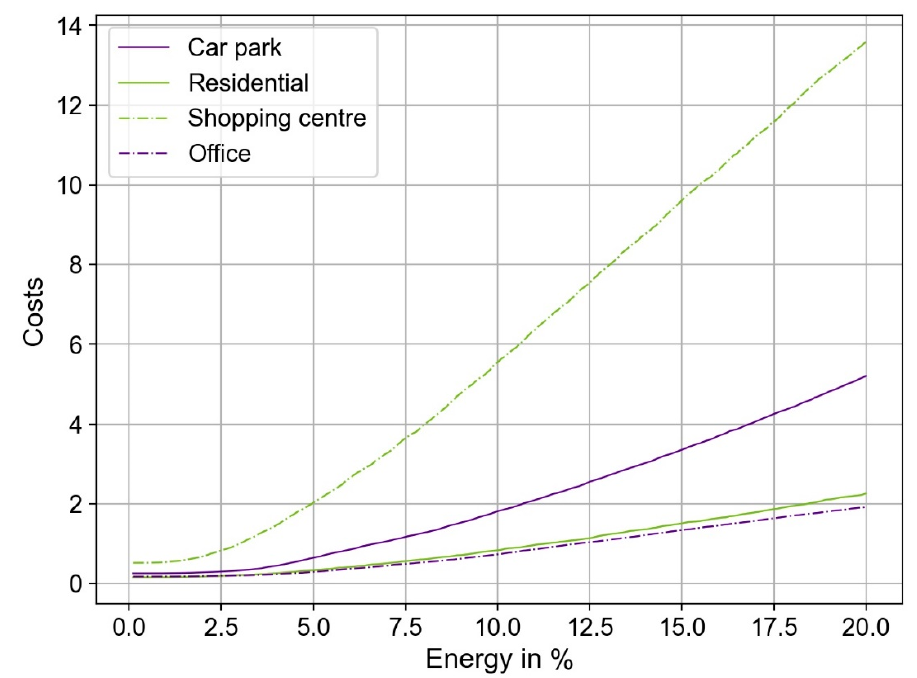
Figure 7. Cost function for each category of charging